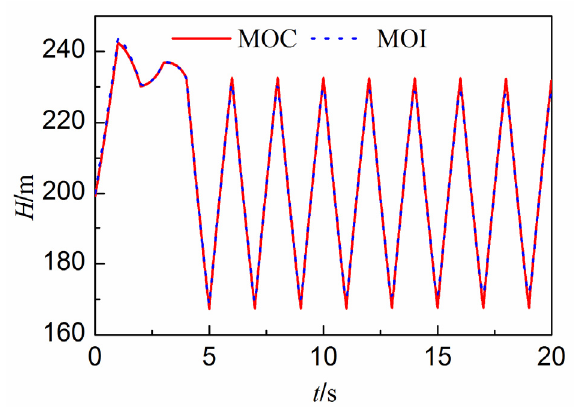
Figure 4. Pressure head traces at the valve for Case 2.